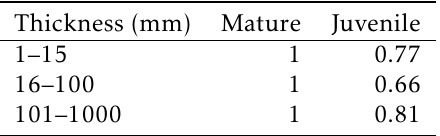
Figure 7: Fragility functions for mature and juvenile rice crops; see Table 9 for the vulnerability coefficients cal- culated from the set of functions. Table 9: Vulnerability coefficients calculated from the set of functions for the fragility functions for mature and juvenile rice crops shown in Figure 7.